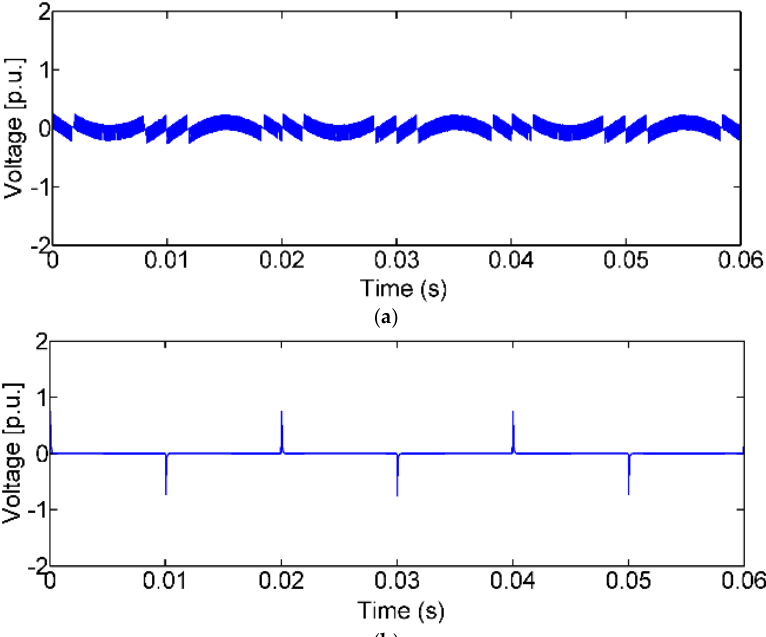
Figure 11. Trapezoidal waveform modulation of the proposed hybrid MMC when λ = 0.